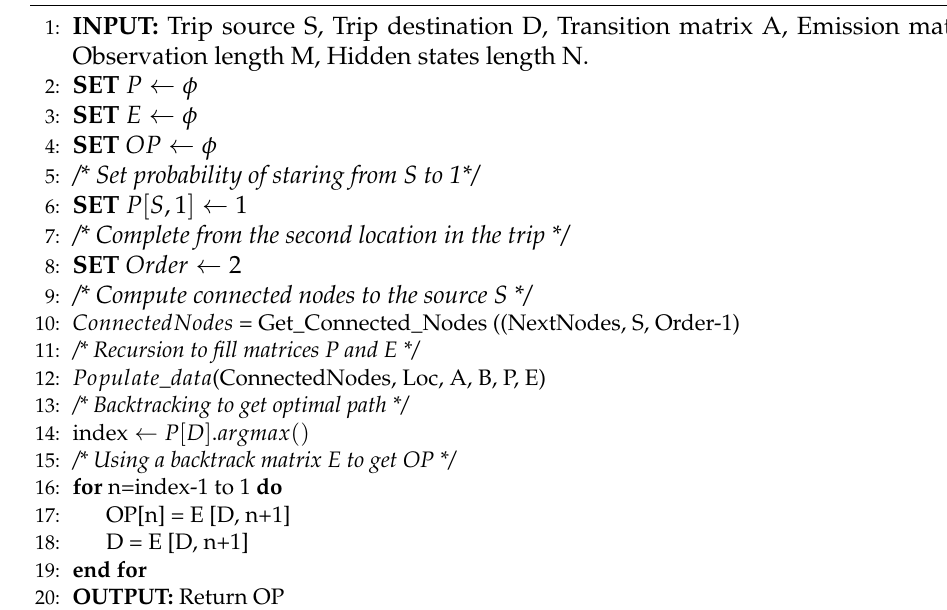
Algorithm 1 Adaptive Viterbi